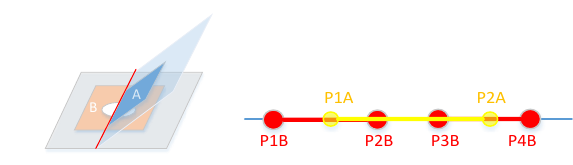
Figure 2. Topological relations of two planar regions with holes